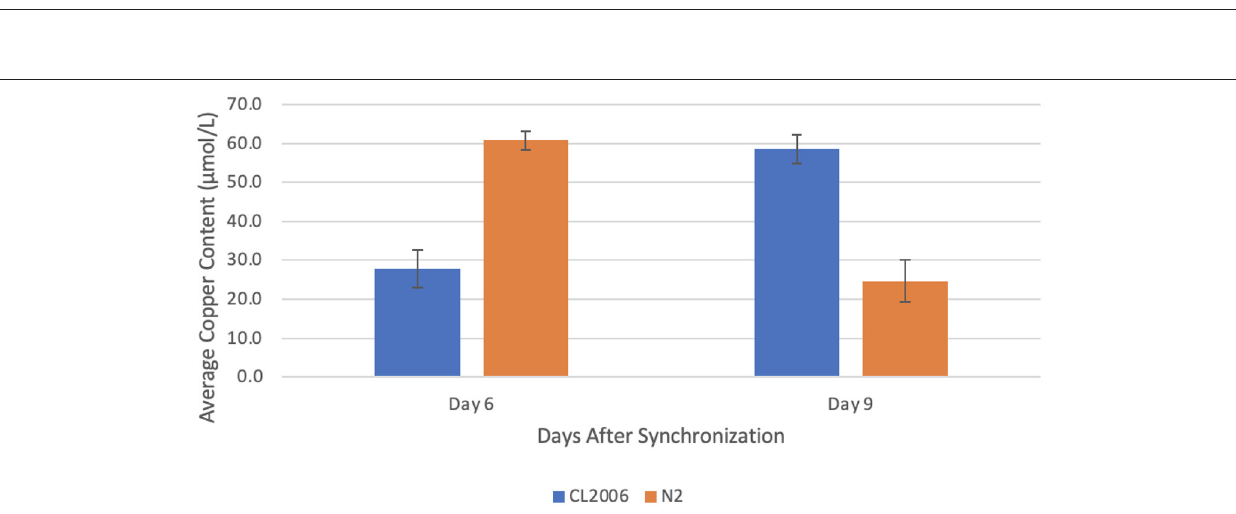
FIGURE 1 | Average zinc content in C. elegans supplemented with copper. When amyloid-beta producing C. elegans (CL2006) were supplemented with copper, a statistically significant ( p = 0.013) increase in the average zinc content occurred from day 6 (13.5 ± 0.6 µ mol/L) to day 9 (20.1 ± 0.9 µ mol/L). Similarly, when non-amyloid-beta producing C. elegans (N2) were supplemented with copper, a statistically significant ( p = 0.041) increase in the average zinc content occurred from day 6 (16.0 ± 0.9 µ mol/L) to day 9 (19.3 ± 0.6 µ mol/L). Values are mean ± SEM and are representative of 2 experiments where 30 C. elegans were analyzed at each time point.